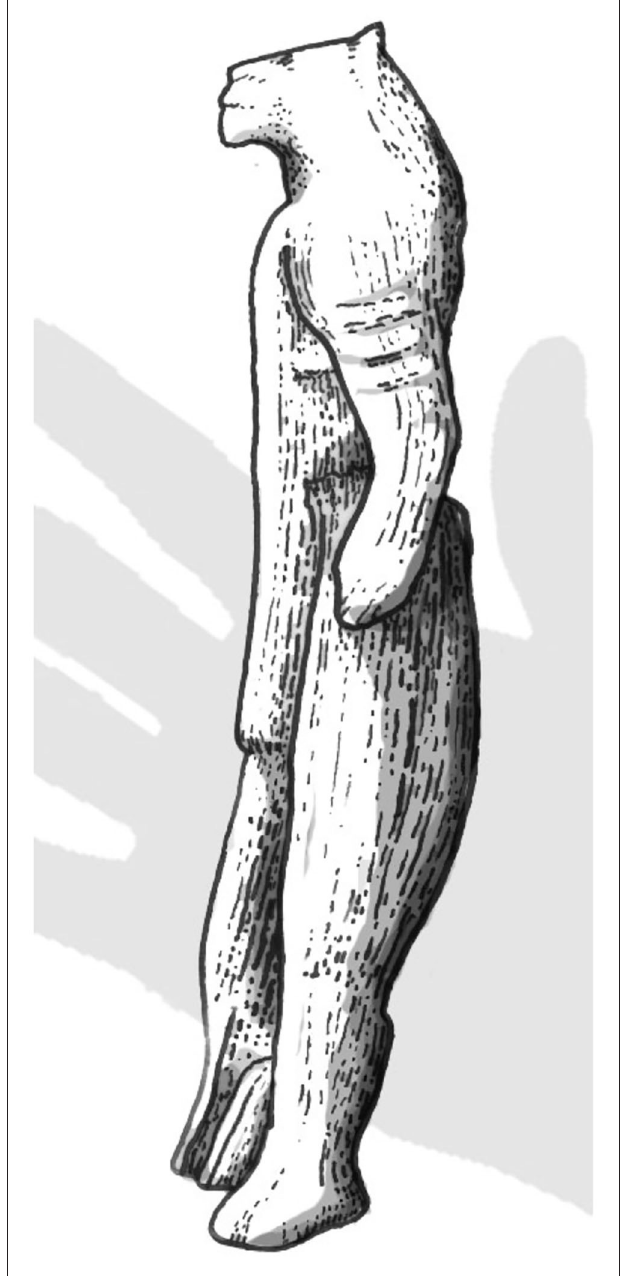
FIGURE 1 | Sketch of the Löwenmensch or “lion-man” figurine from the Hohlenstein-Stadel cave in Germany. According to the Ulm Museum, 14 C dates put it at an age of 35,000 to 40,000 years. The hand indicates its relative size (Obtained with permission from the artist, Cameron